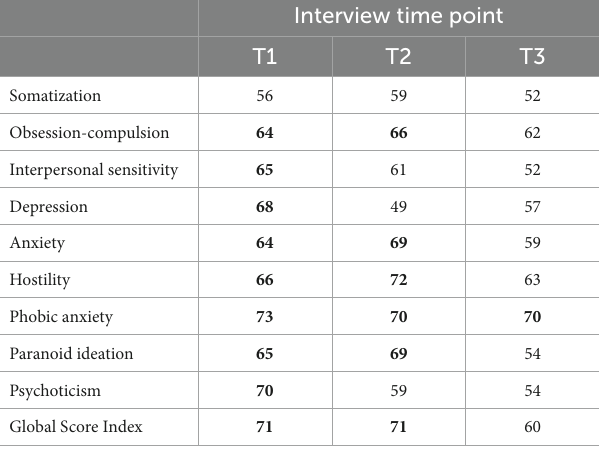
TABLE 2 BSI scores at each interview time point.